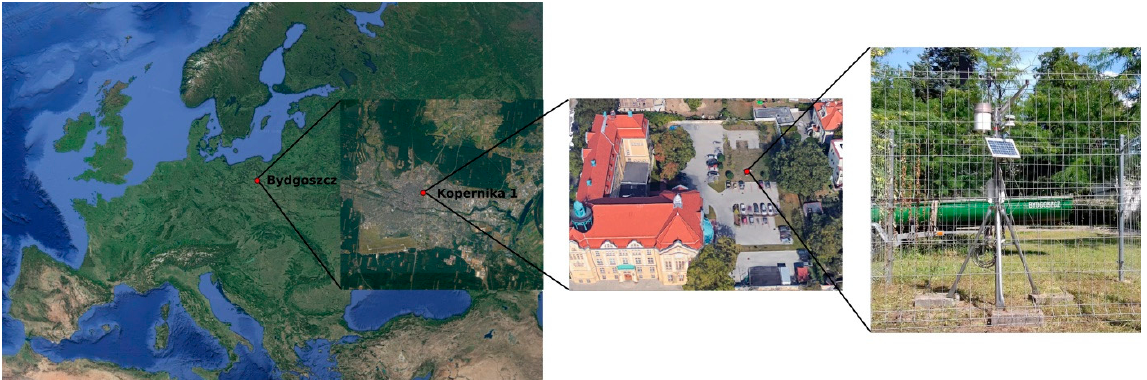
Figure 2. The location of the measuring station .